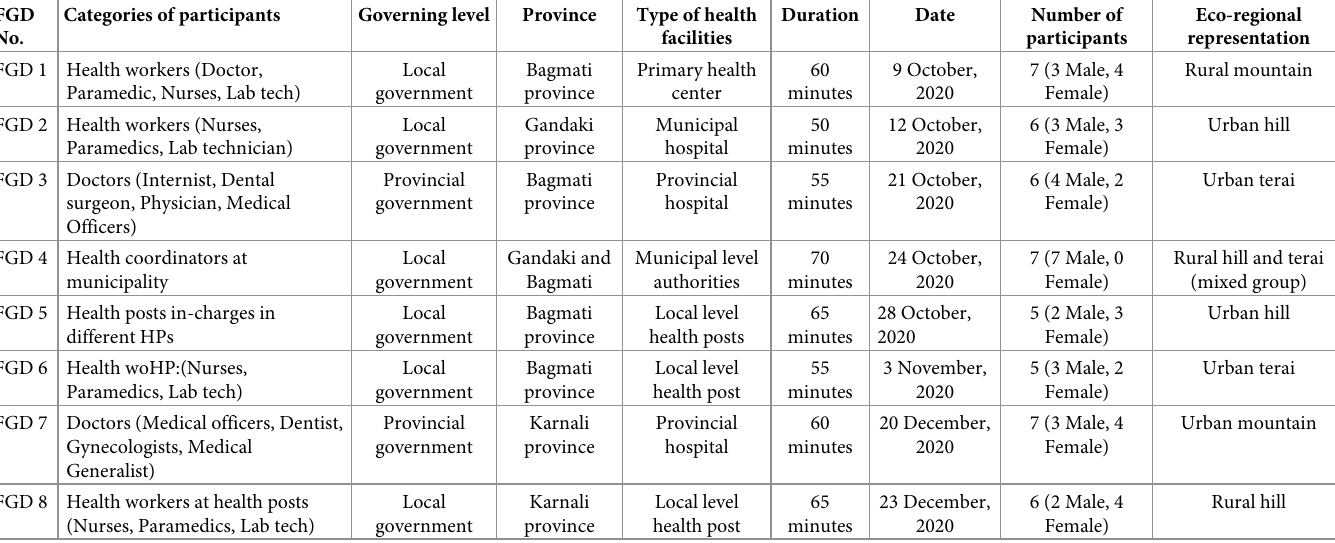
Table 2. Characteristics of FGDs participants. FGD